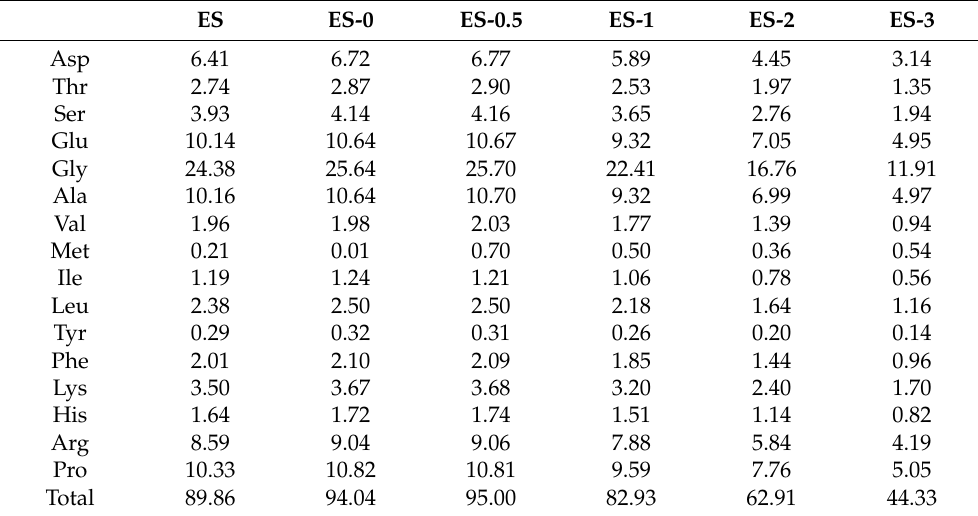
Table 5. Amino acid composition (Amino acids g/100 g protein) of Esox lucius scale gelatin.